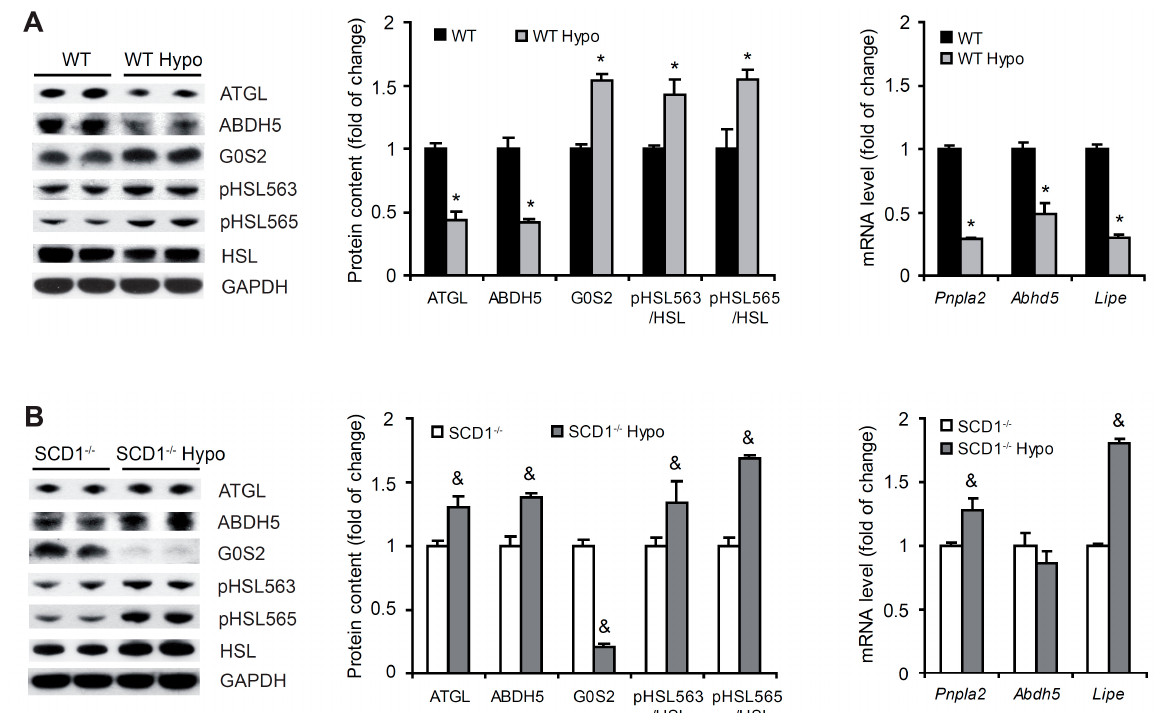
Figure 4. Effect of SCD1 deficiency and hypothyroidism on lipolysis in cardiomyocytes. Protein levels of adipose triglyceride lipase (ATGL), α / β -hydrolase domain containing 5 (ABDH5), G 0 /G 1 switch protein 2 (G0S2), hormone-sensitive lipase (HSL), and phosphorylated HSL (pHSL) at Ser563 and Ser565 in cardiomyocytes in ( A ) wildtype (WT) and ( B ) SCD1 − / − mice were determined by Western blot. mRNA levels of Pnpla2 , Abdh5 , and Lipe were determined in the heart in WT and SCD1 − / − mice by real-time polymerase chain reaction. The data are representative of n = 5 animals/group. The data are expressed as mean ± SD. * p < 0.05, vs. WT; & p < 0.05, vs. SCD1 − / −